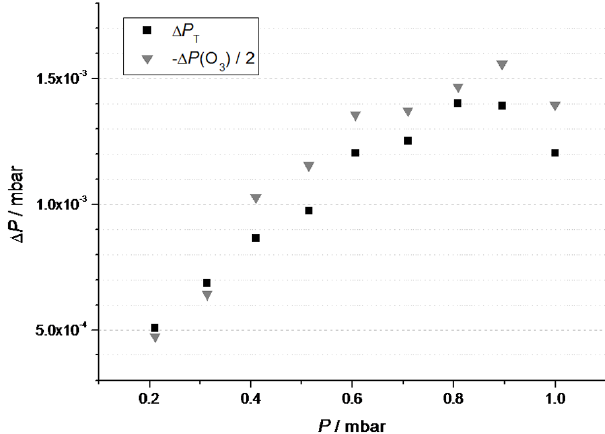
Figure 3. Increase of the total pressure (cid:49)P T while ozone is in the absorption cell compared with half the decrease of the ozone partial pressure (cid:49)P (O 3 ) during the same